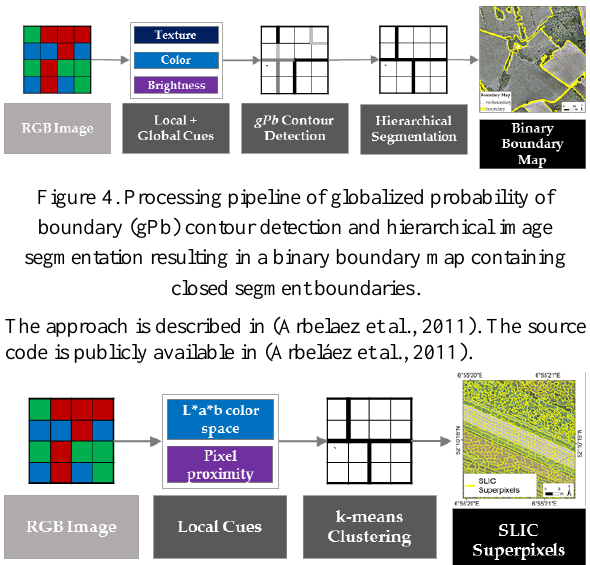
Figure 5. Processing pipeline of simple linear iterative clustering (SLIC) resulting in agglomerated groups of pixels, i.e., superpixels, whose boundaries outline objects within the image The approach is described in (Achanta et al., 2010) and extended in (Achanta et al.,